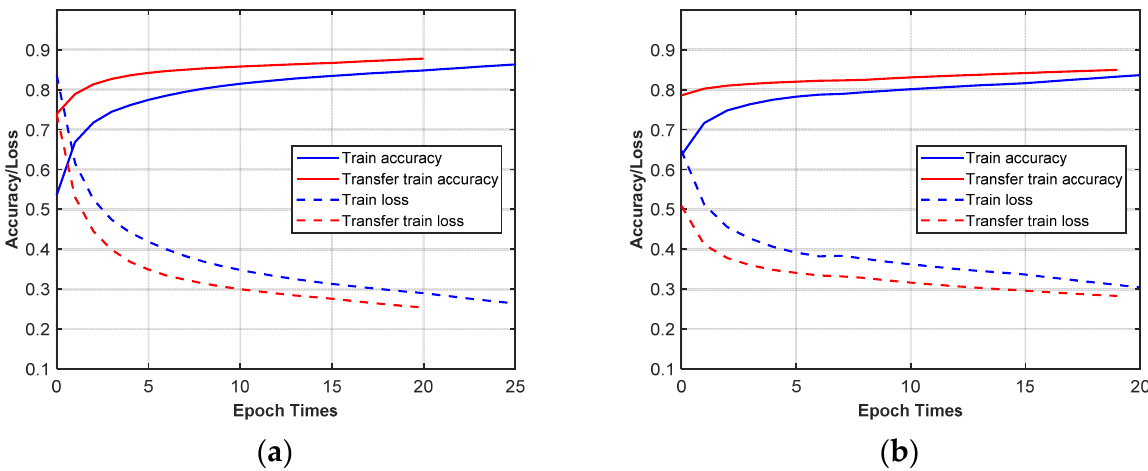
Figure 14. Training/validation curves of accuracy and loss (blue lines: without transfer learning; red lines: with transfer learning. ( a ) Training on MPSK transfer to MQAM at N = 512; ( b ) training under AWGN transfer to non-Gaussian for MQAM at N = 512.